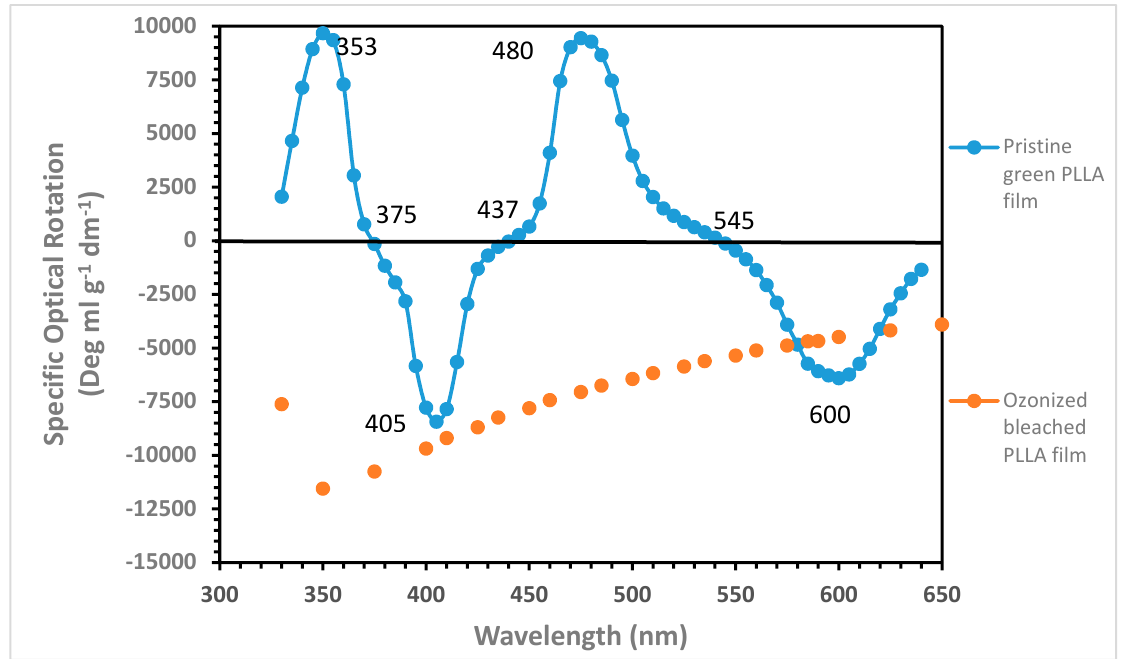
Figure 8. Optical rotatory dispersion (ORD) of thin solid film (30 μ m thick) of PLLA (blue line and dots) from used water bottles with combined green and blue pigment with strong anomalous Cotton effect; same thin solid film of PLLA after exposure to ozone (orange line and dots); reference PLLA ORD curve 412 mg dissolved in 100 mL of CHCl 3 .